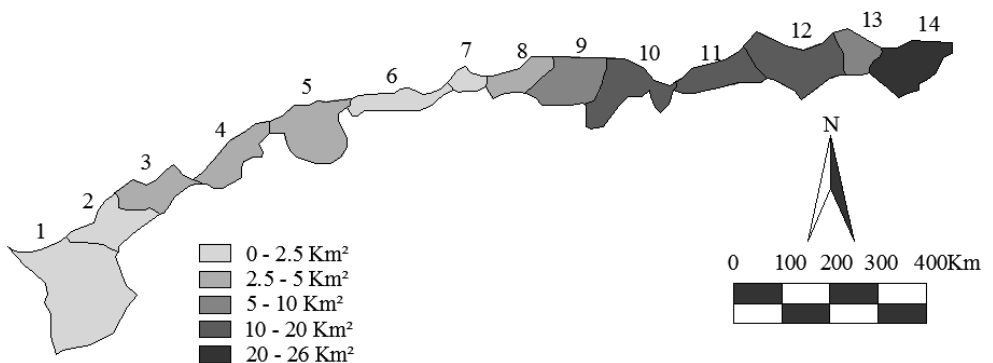
Figure 17. Deforestation of the Algerian coast during 2009–2015 by department: 1—Tlemcen, 2—Ain